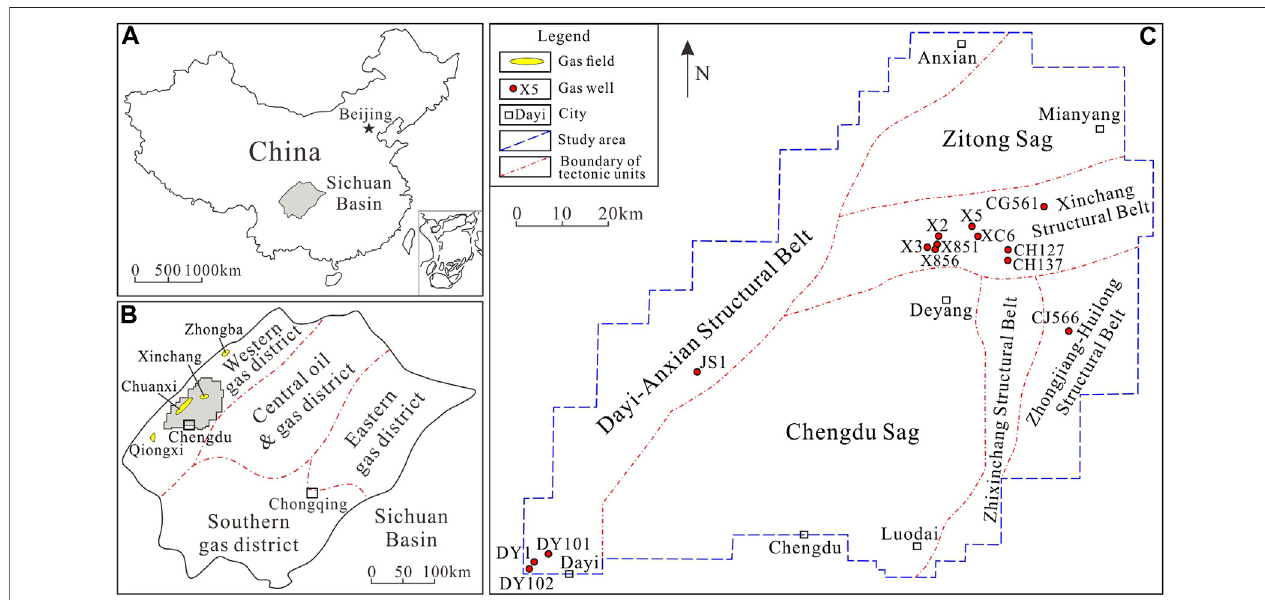
FIGURE1| ThepositionoftheSichuanBasininChina (A) ,thelocationofthedepressionintheSichuanBasin (B) ,anddistributionofgaswellsandstructuralunitsin the Western Sichuan Depression (C) .